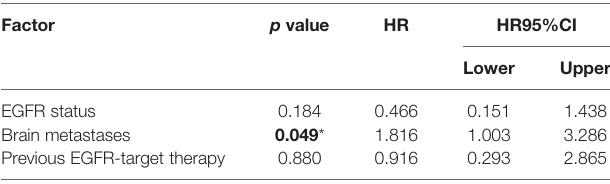
CI, con fi dence interval; EGFR, endothelial growth factor receptor; HR, hazard ratio. The bold value with symbol * indicates statistically signi fi